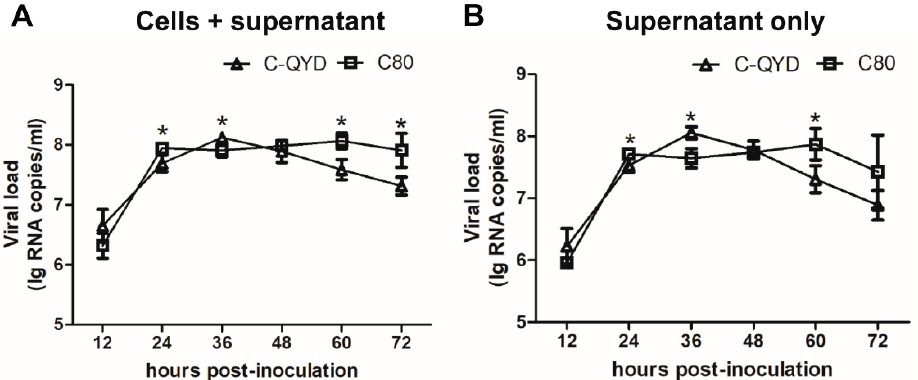
Figure 1. Growth kinetics of DHAV-1 in DEF cells. The fifth cell passage viruses of C-QYD and C80 were used to inoculate DEF cells at a MOI corresponding to one copy/cell. Viral yields in DEF cells were reflected by RNA copies detected with RT-qPCR. At each time point, cells + supernatant ( A ) and supernatant only ( B ) were respectively collected from three wells of 24-well plates. Error bars represent the SD ( n = 3); * p < 0.05.